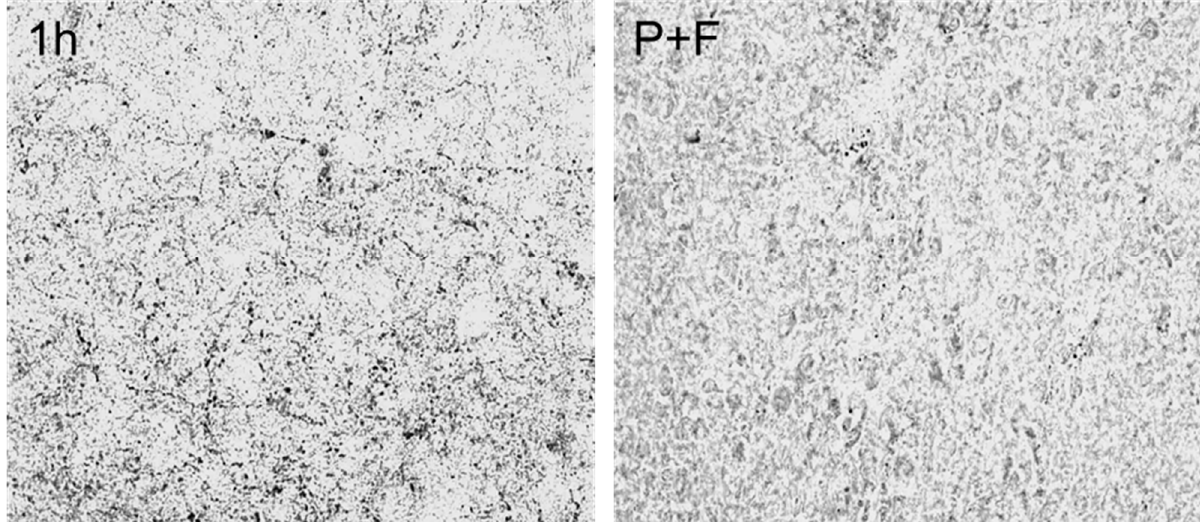
Figure A8. Methionin-enkephalin immunoreactivity in the suprachiasmatic nucleus of Syrian hamsters. Comparison between 1 h manual sleep deprivation (1 h, group 3a) and sexual stimulation with pheromone and females (P+F, group 1). Magnification: 200×.